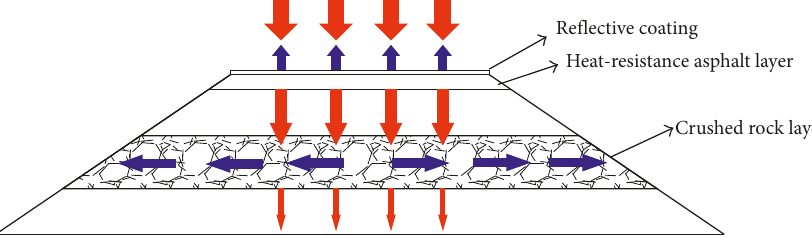
Figure 1: Schematic diagram of the reflective-resistant-ventilated coupling structure.